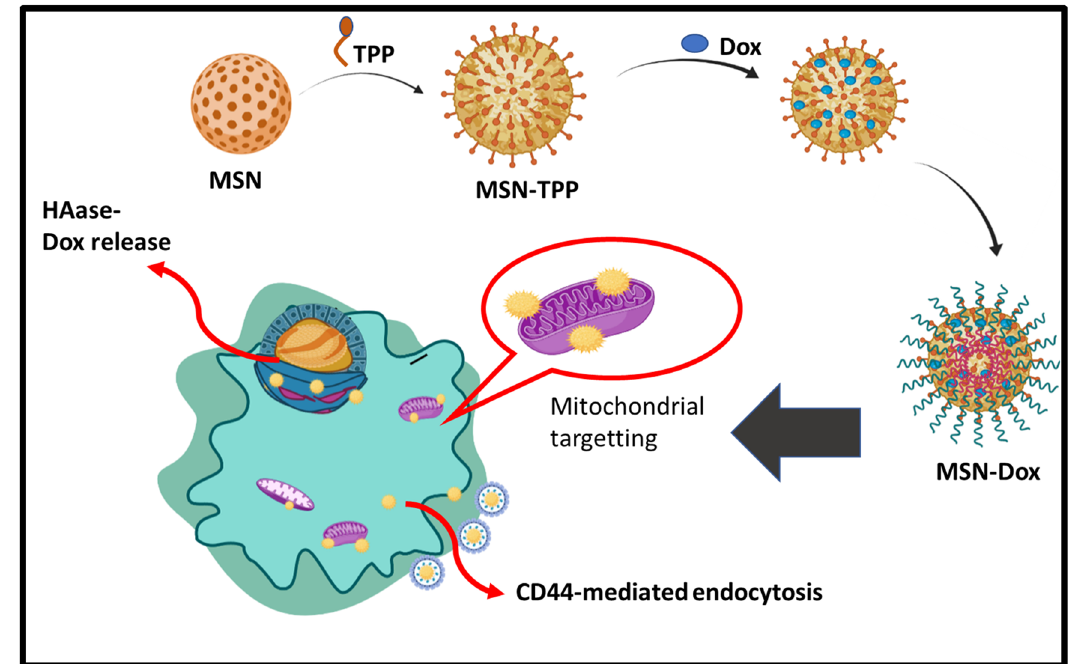
Figure 5: Schematic representation of enzyme responsive